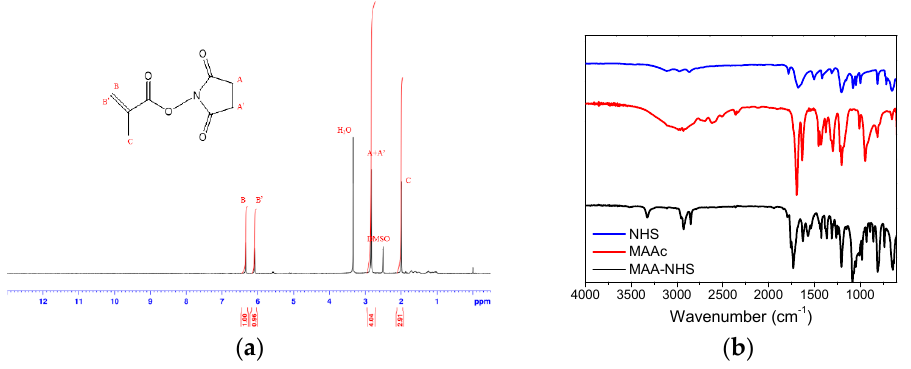
Figure 2. ( a ) 1 H NMR and ( b ) FT-IR spectra of MAA–NHS.